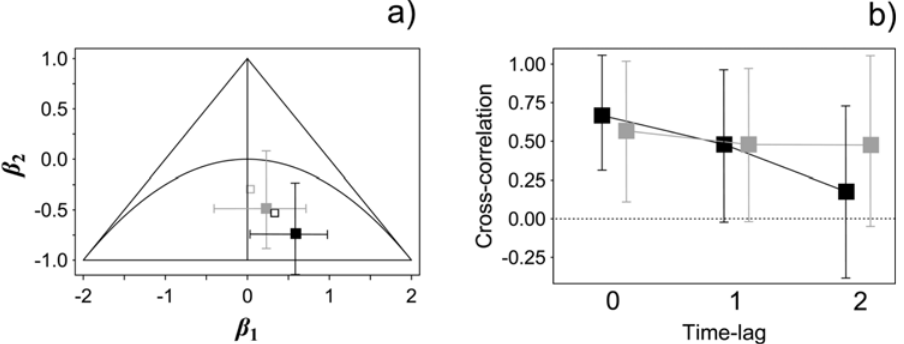
Figure 2. a) Royama diagram [ 19 ] , showing the dynamics of the second-order model in the parameter space. Outside the triangle, populations tend to extinction, and below the parabola multiannual cycles arise; within the area between the triangle and the parabola the system exhibit